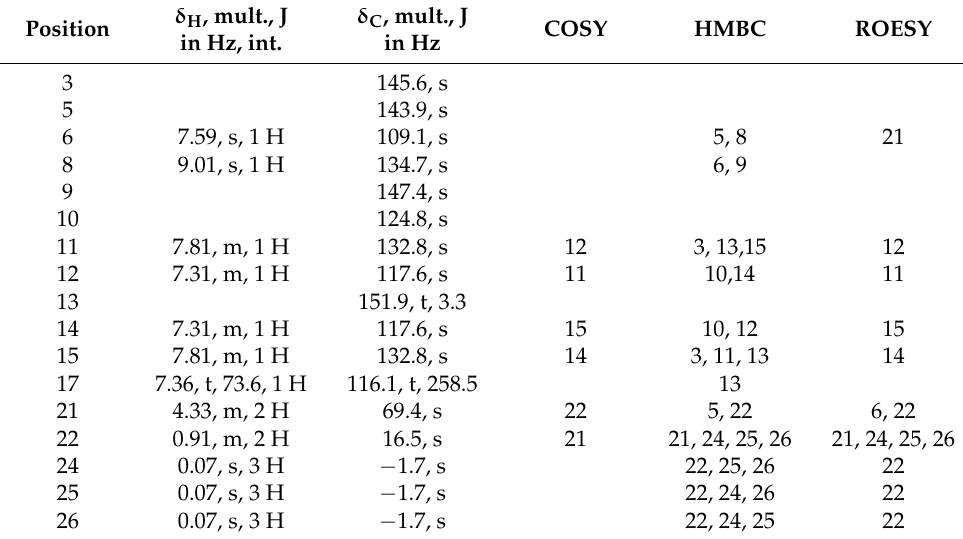
Table 1. NMR data for compound 5 in DMSO- d 6 a . δ H , mult., Position